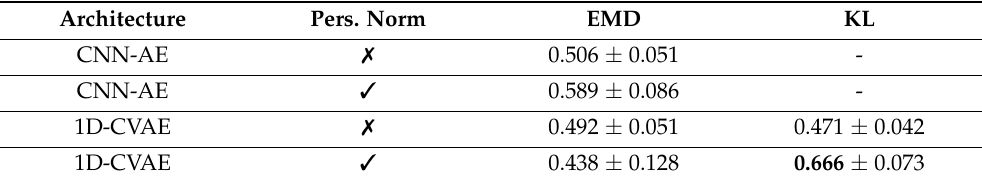
Table 16. Average ROC-AUC scores for the discrimination between stable and anomalous (pre- relapsing or relapsing) patients’ condition for the HRV autoencoder, depending on the architecture, normalization scheme and anomaly score.